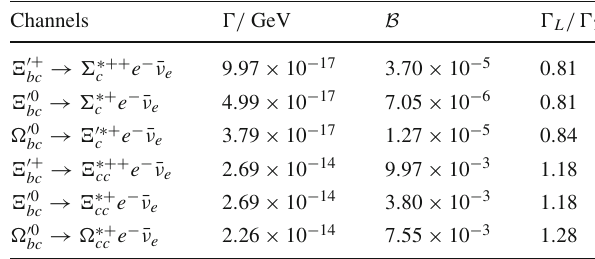
Table 15 Semileptonic decays for the bc (cid:3) sector with b quark